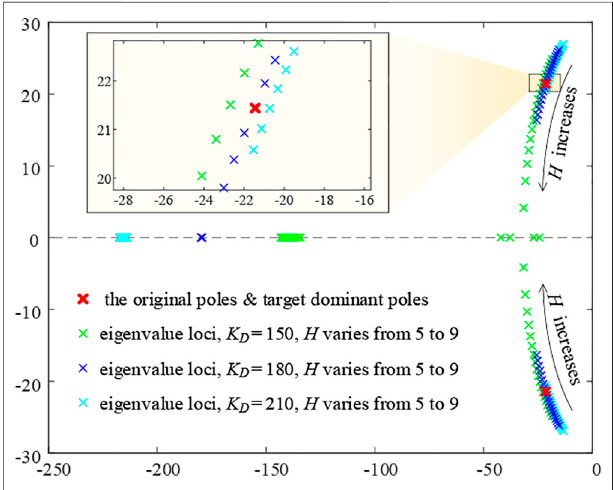
FIGURE 7 | Eigenvalue loci when H or K D